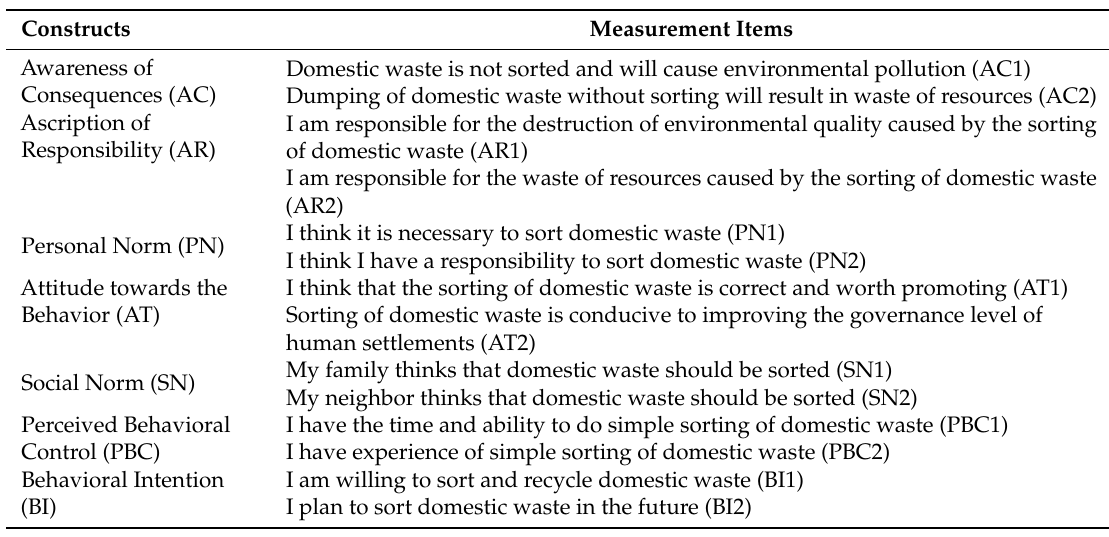
Table 1. Measurement items on domestic waste sorting attitude and behavior